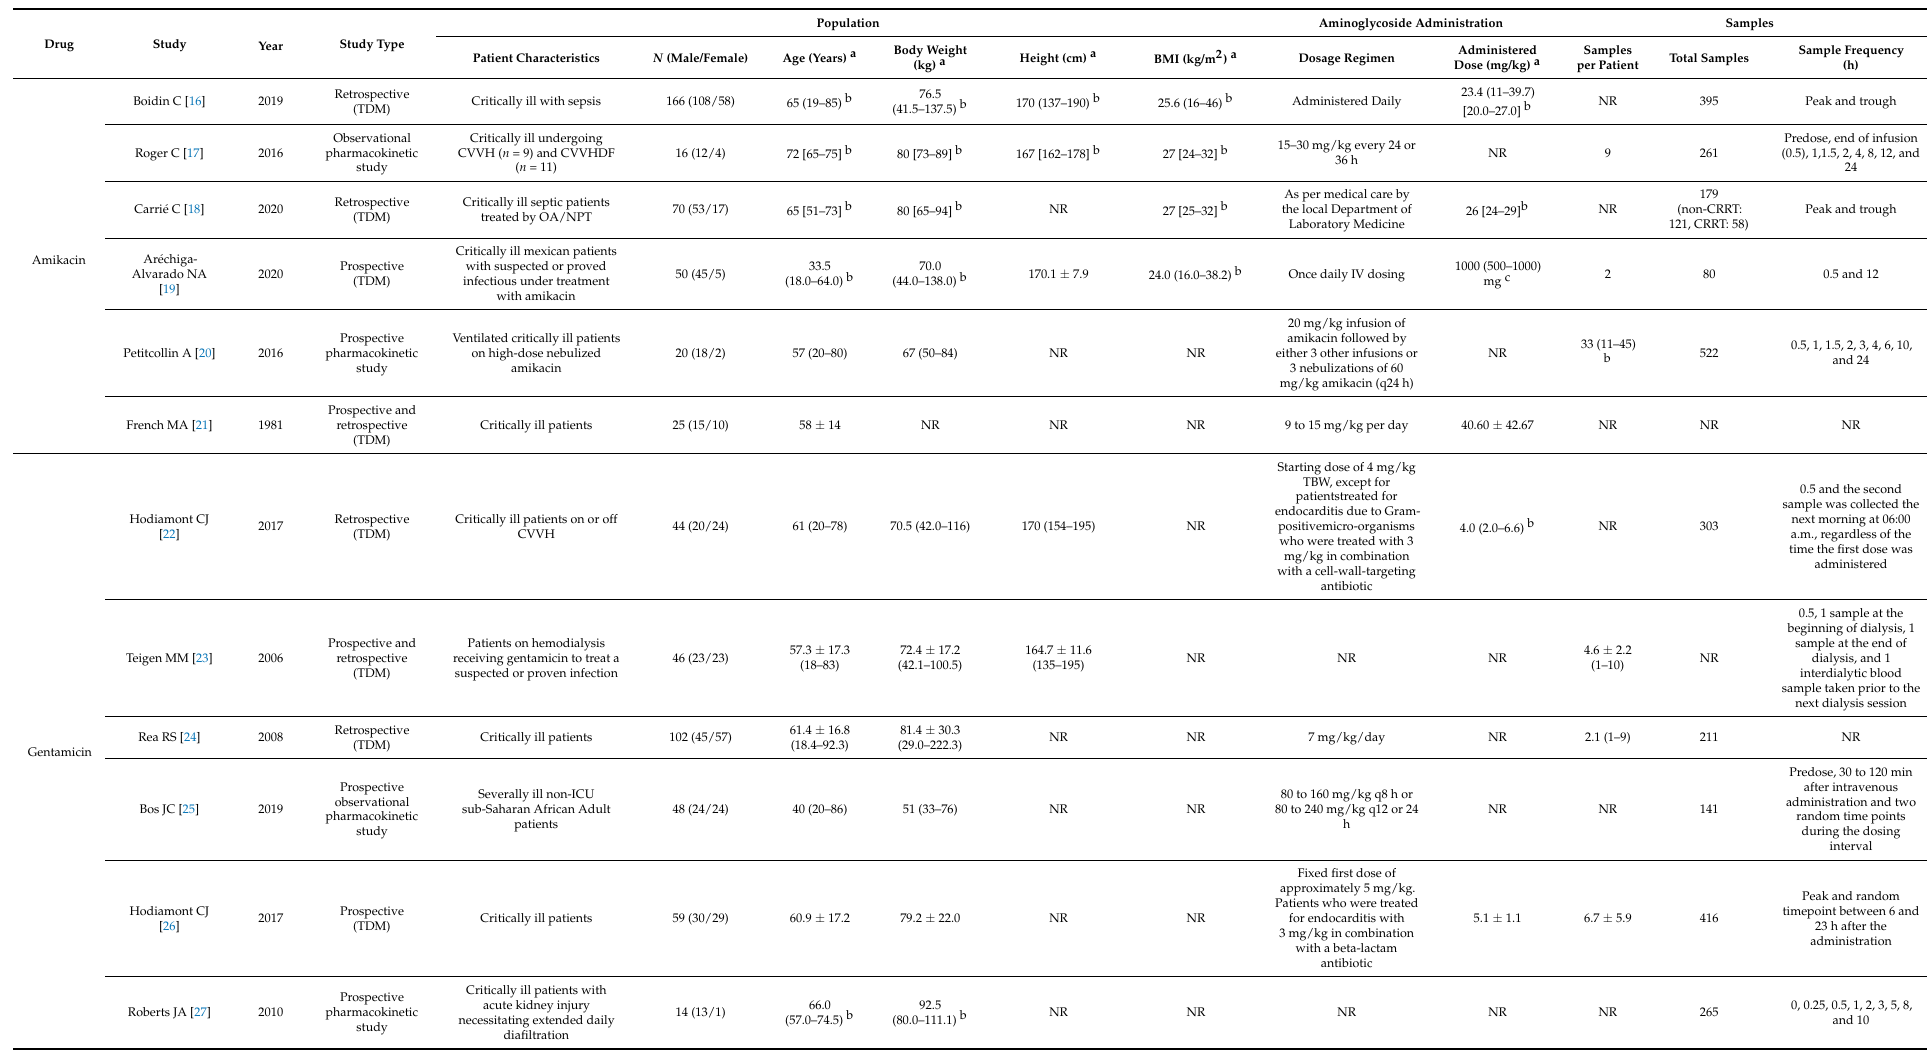
Table 1. Summary of patients’ demographics and clinical protocol for all population pharmacokinetic studies included in this review for amikacin, gentamicin, and